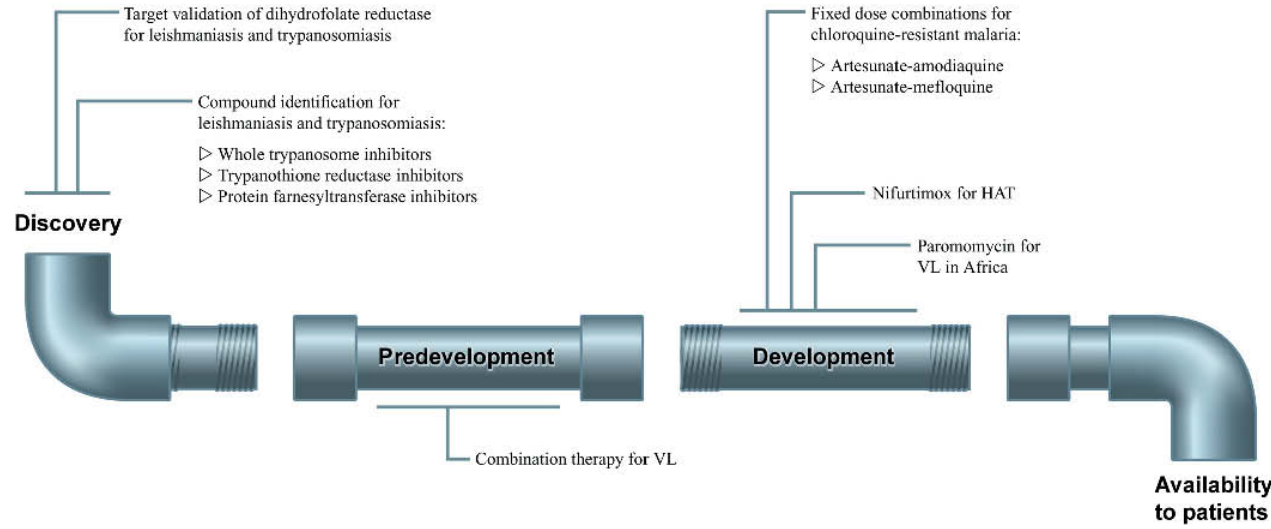
Figure 2. DNDi Projects DNDi’s project portfolio contains nine projects spread out across the drug development pipeline for the treatment of leishmaniasis, sleeping sickness, Chagas disease, and malaria. HAT, human African trypanosomiasis (sleeping sickness); VL, visceral